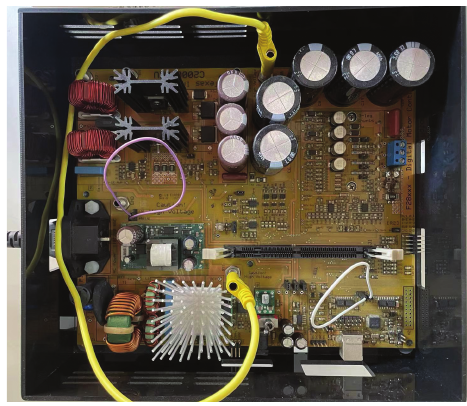
Figure 24. TI HVMTRPFCKIT